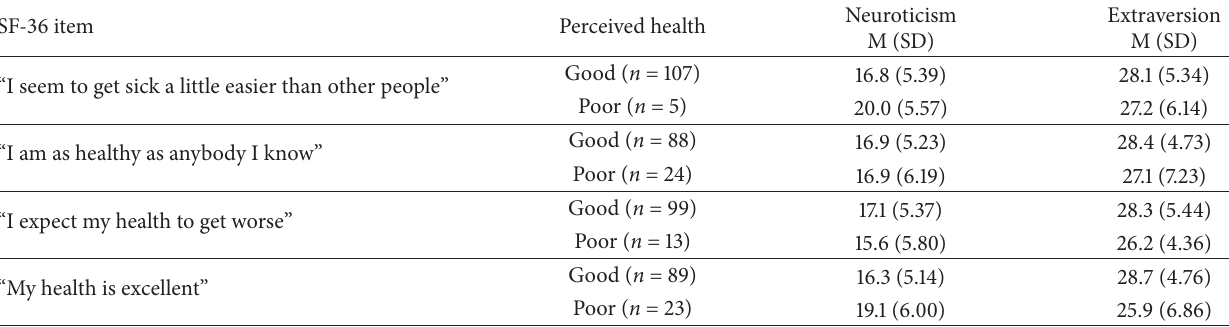
Table 2: Personality dimensions associated with good and poor perceived health.